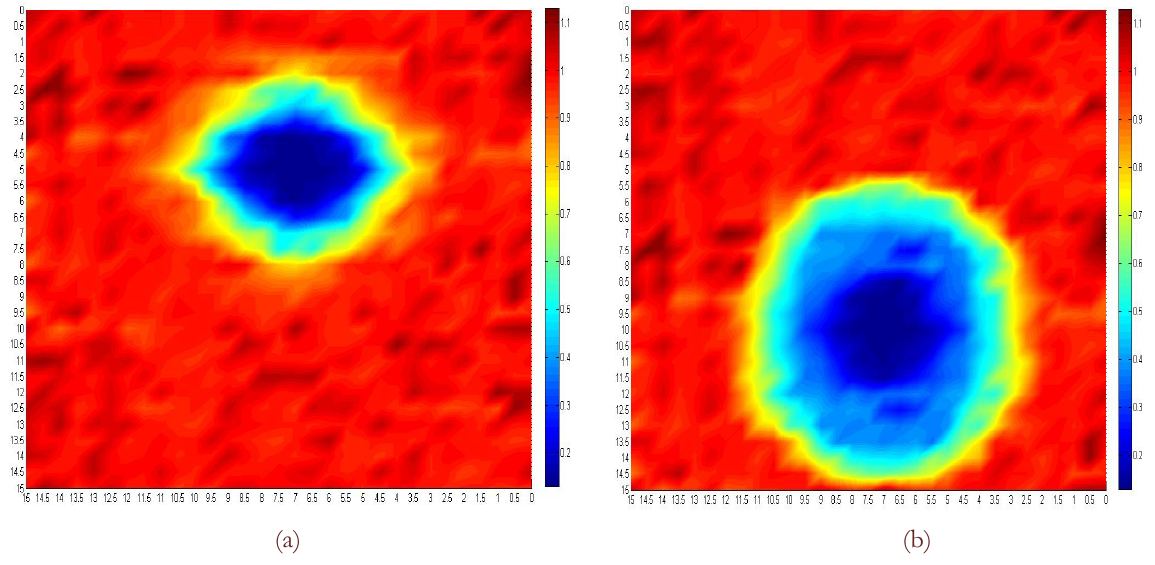
Figura 14: Mappa cromatica che identifica l’estensione dell’area di contatto relativa ad un carico di 900 N (a) e di 2700 N (b). Figure 14: Color maps identifying the extension of the contact area relative to a load of 900 N (a) and 2700 N (b).